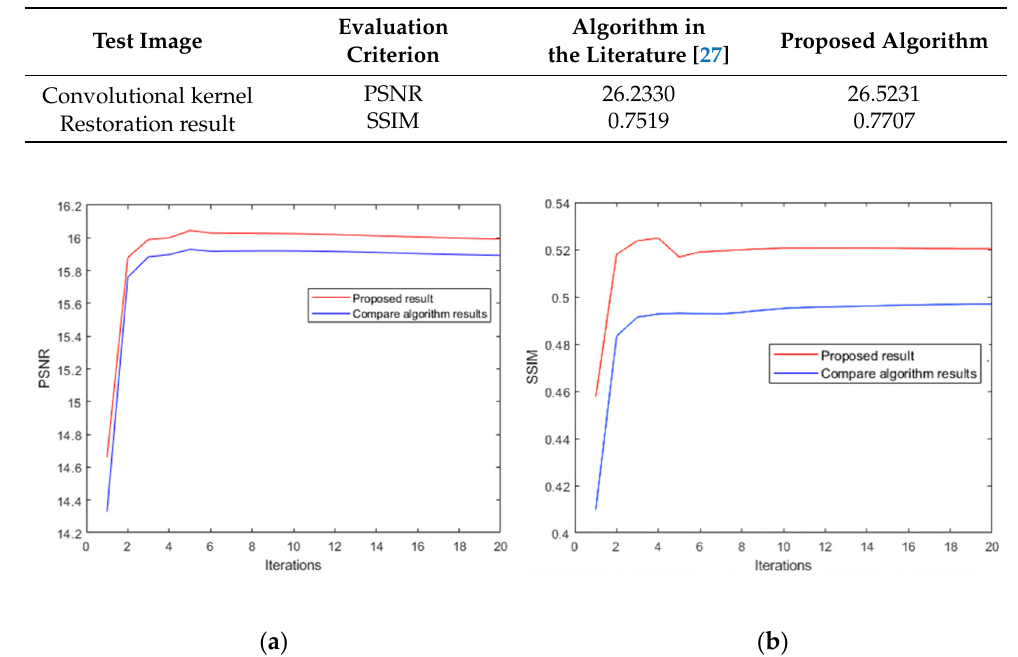
Table 4. Final result of RGO deblur and [27].